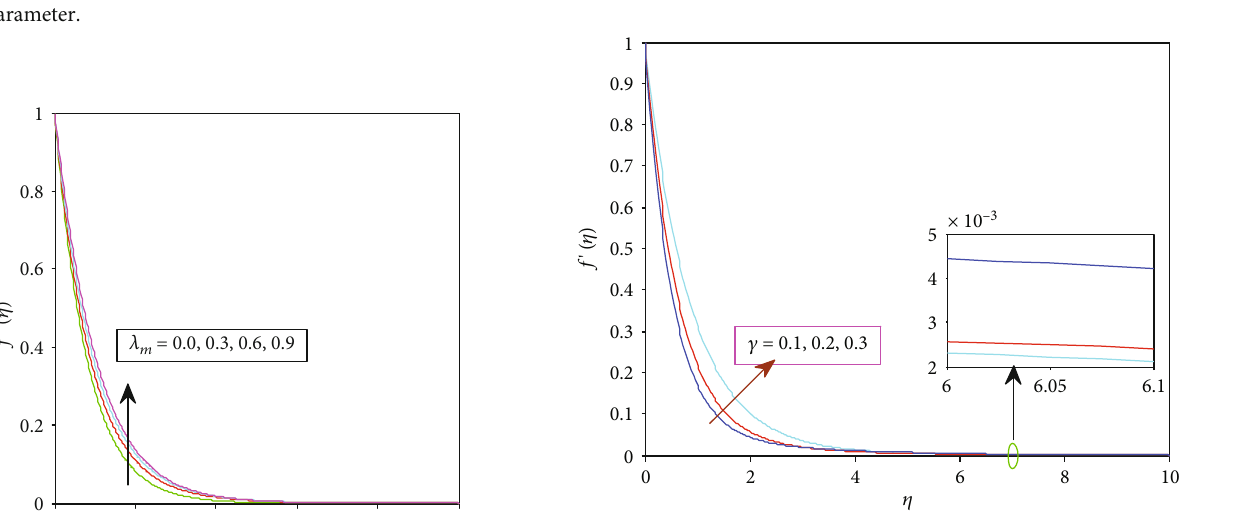
Figure 6: Velocity distribution for di ff erent values of the curvature parameter.